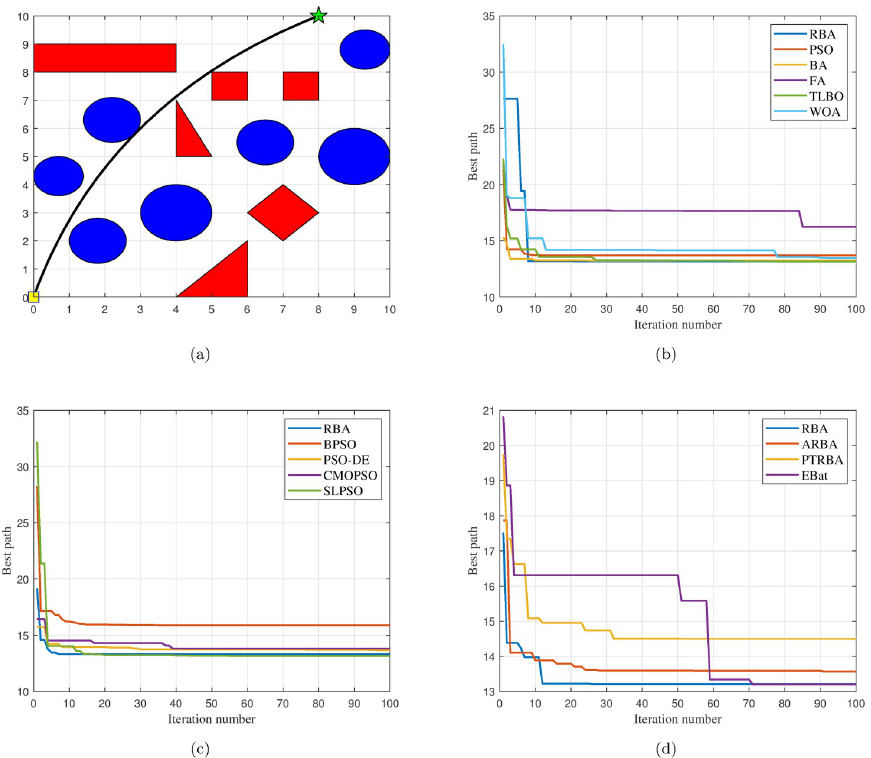
Fig 9. The path planning results in the test case 2 and the number of iterations of all algorithms when the path is implemented. (a) Optimal path. (b) Iteration curves of RBA and classical algorithms. (c) Iteration curves of RBA and PSO variants. (d) Iteration curves of RBA and BA